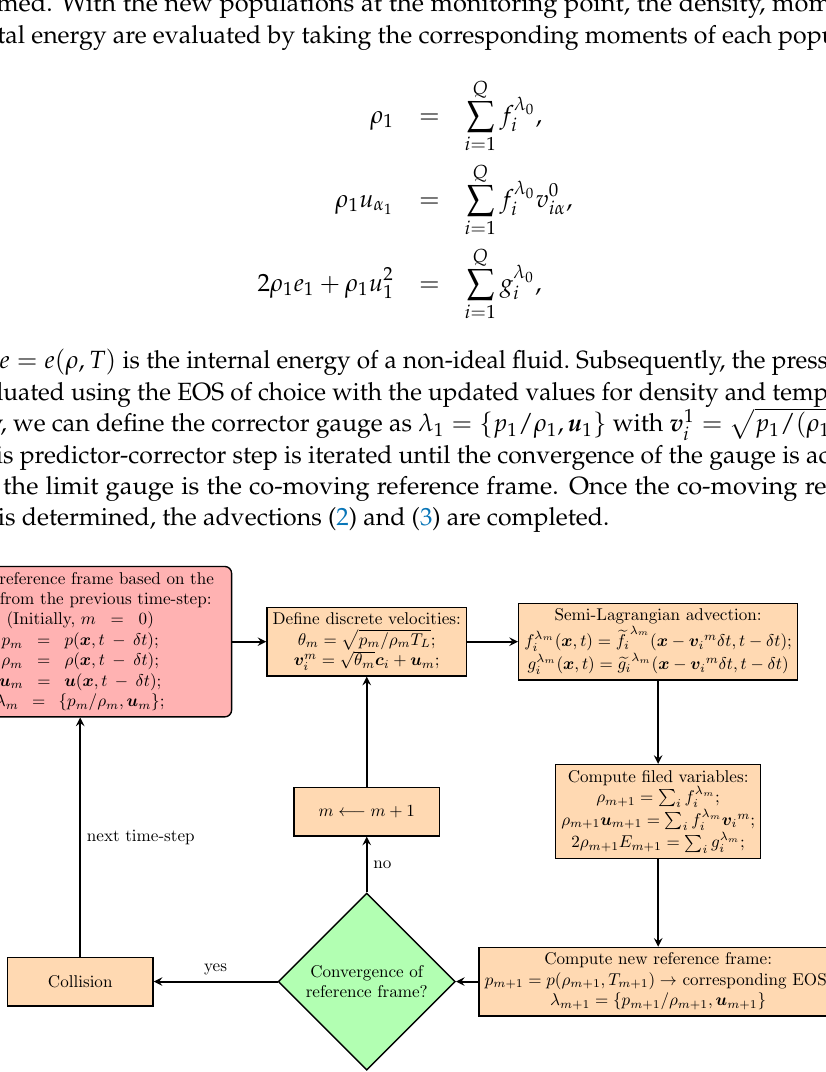
Figure 1. Flowchart of the semi-Lagrangian advection using the predictor-corrector